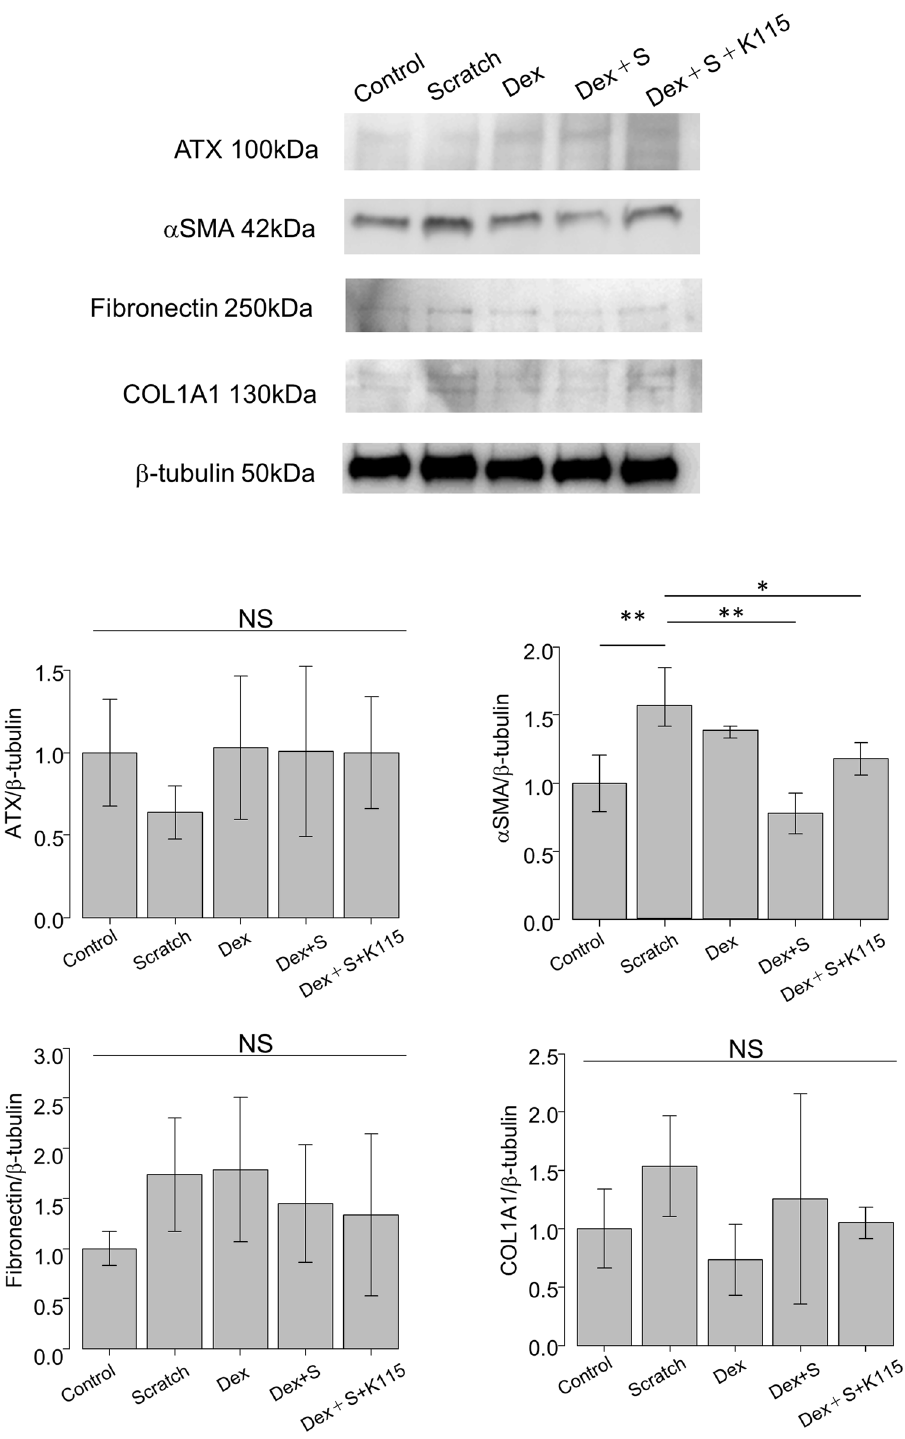
Figure 5. Western blotting of ATX and fibrotic markers in hTM cells. Western blotting of ATX, aSMA, fibronectin and COL1A1 in hTM cells. The representative bands are shown in ( A ), and the relative expression of ATX, aSMA, fibronectin and COL1A1 compared to the loading control (β-tubulin) are shown in ( B ) (n = 3). * P < 0.05, ** P <